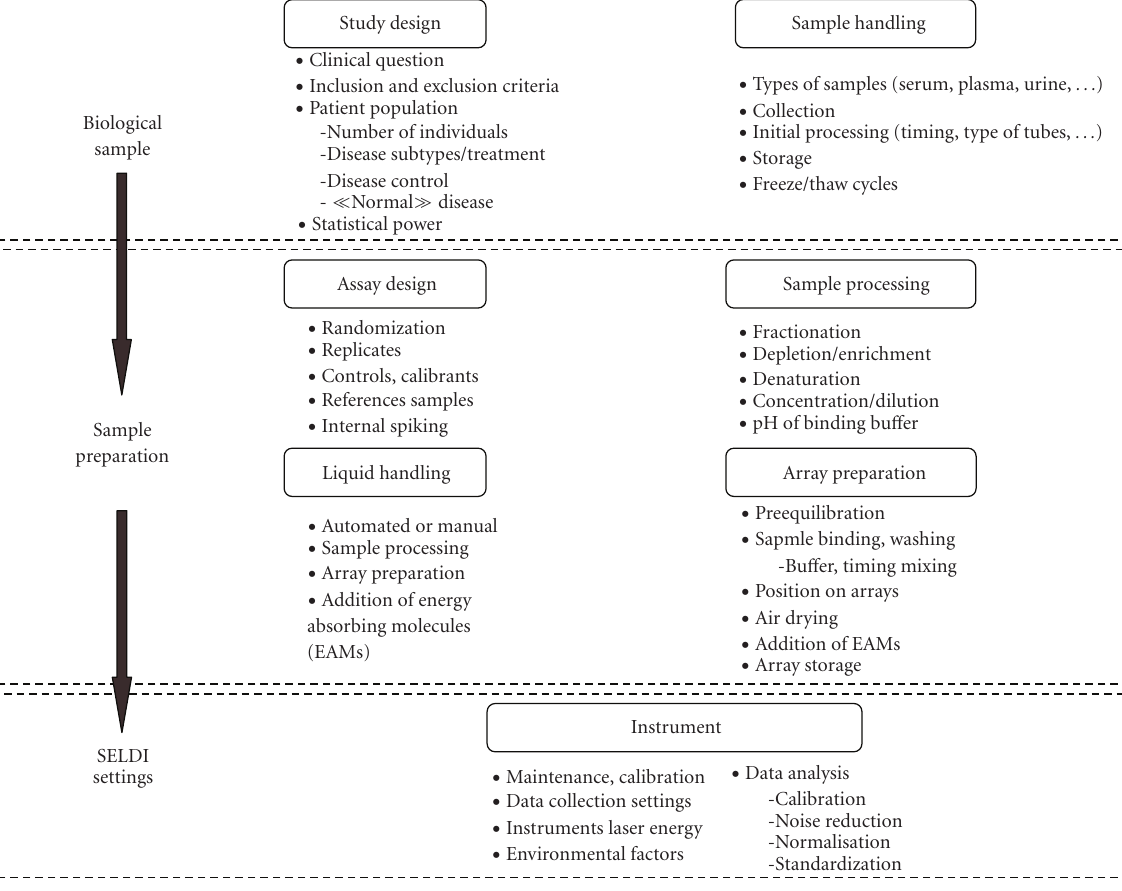
Figure 2: Experimental variables that can a ff ect proteomics data. Most of the steps shown are involved in all proteomics workflows, but SELDI technology performs many of them on a single